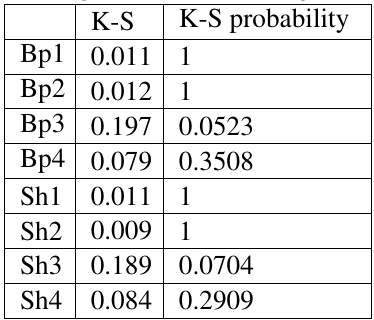
Table 9 Four-stage K-S test of the marginal distribution